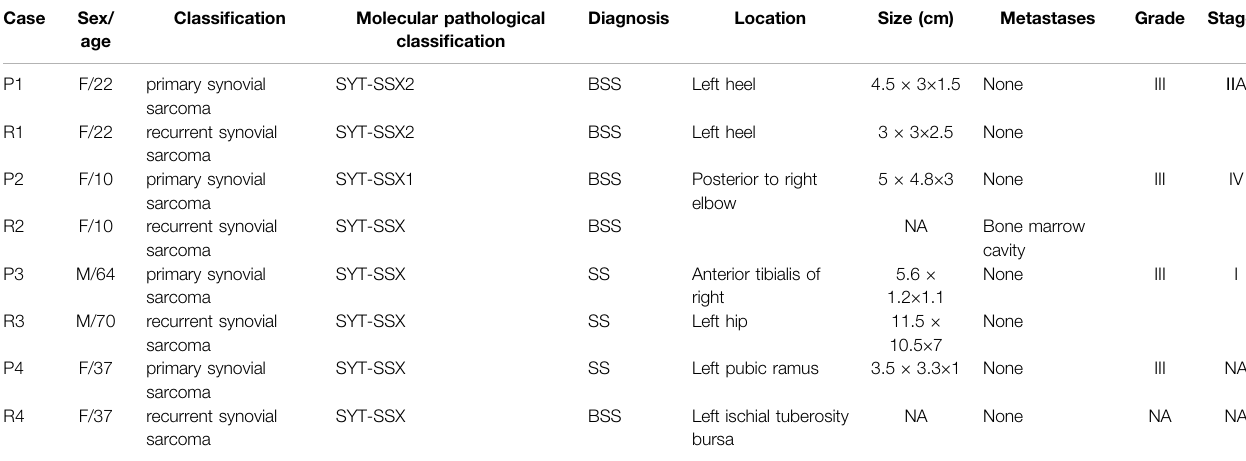
TABLE 1 | The basic information of the